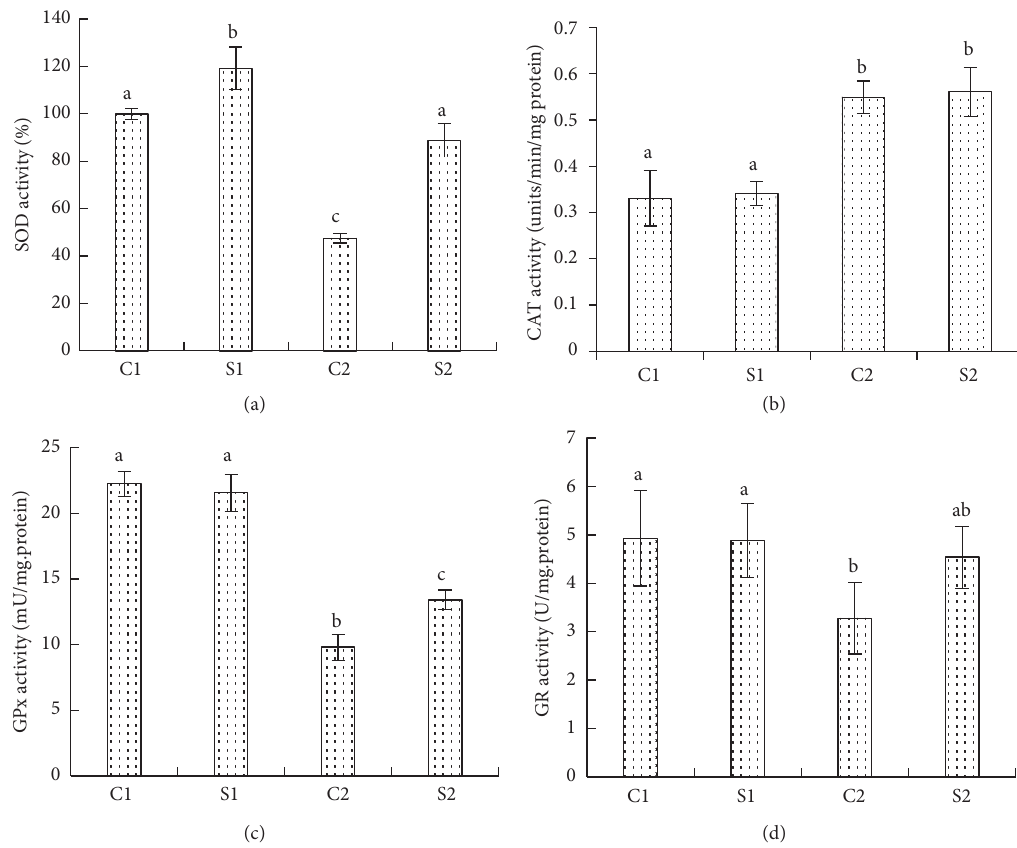
Figure 4: Effects of MKAVCFSL on the cellular antioxidant enzyme. (a) SOD activity, (b) CATactivity, (c) GPx activity, and (d) GR activity. C1: control 1, medium treatment without H 2 O 2 and peptide; S1: sample 1, peptide treated only; C2: control 2, H 2 O 2 treated only; S2: sample 2, medium treatment with H 2 O 2 and peptide. Results are the means ± SD from three independent experiments. Different small letters indicate significant differences between groups ( p < 0 .